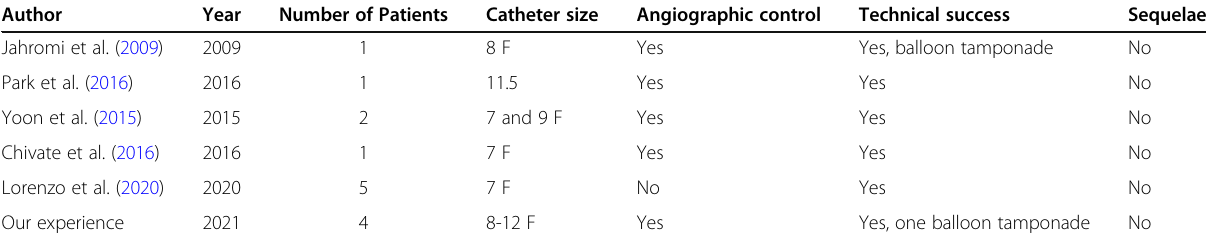
Table 2 Clinical studies reporting the use of Perclose Proglide device for the treatment of iatrogenic subclavian